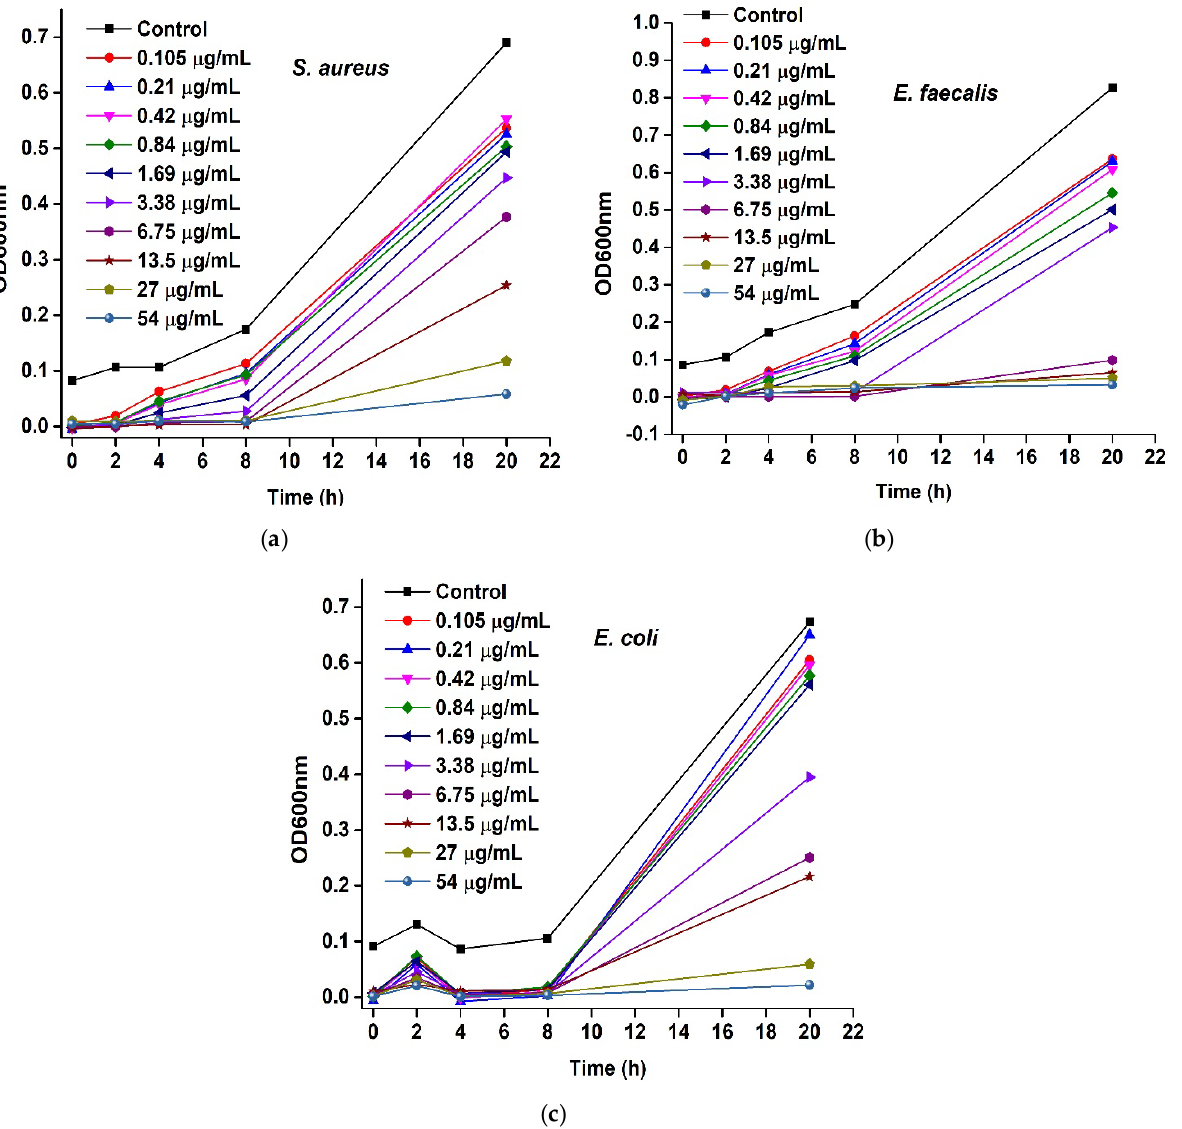
Figure 11. Growth curves of ( a ) S. aureus , ( b ) E. faecalis , and ( c ) E. coli as a function of C-AgNPs concentration.